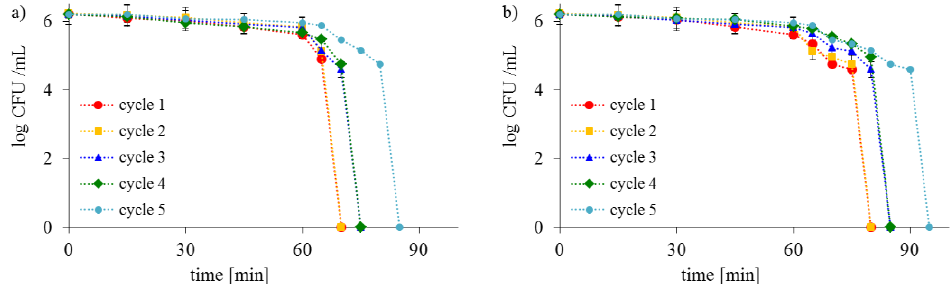
Figure 13. Inactivation of ( a ) E. coli and ( b ) S. epidermidis during the recycled photocatalytic process with TiO 2 -S-1%-100 under ASL irradiation.